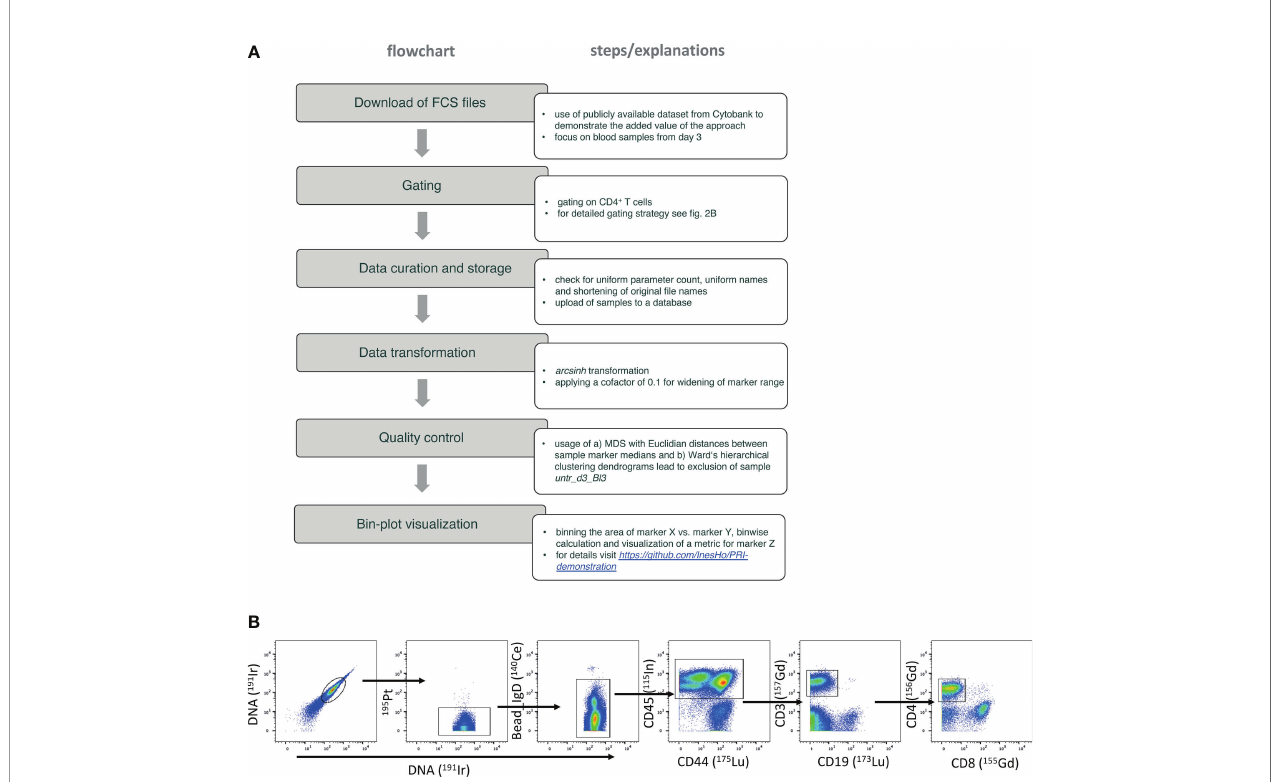
FIGURE 2 | Flowchart of the used PRI-analysis work fl ow. (A) The fl owchart lists the step by step details. (B) Gating strategy focusing on selecting CD4 T helper cells – plots from left to the right show the identi fi cation of live single cells by using the signal of the iridium-DNA-intercalator and the negative expression of cisplatin represented by 195Pt. Left-over internal standard beads were excluded by using high 140Ce signal. CD45 as unique pan-leukocytic marker, and CD3 were used to detect T cells. The very right plot shows the discrimination of CD4 T helper cells from CD8 cytotoxic T